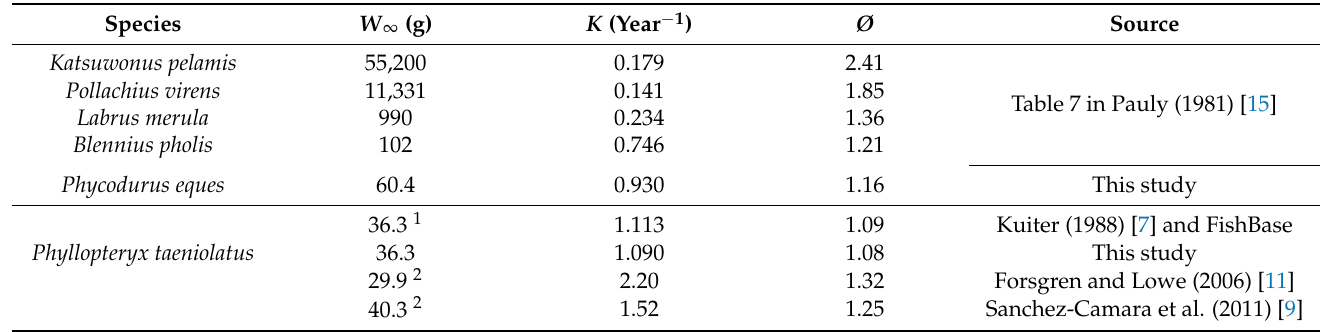
Table 6. Comparison between the growth performance of two species of seadragon and four species of other bony fishes (from Pauly 1981), using the growth performance index Ø = log( K ) + 2/3log( W ∞